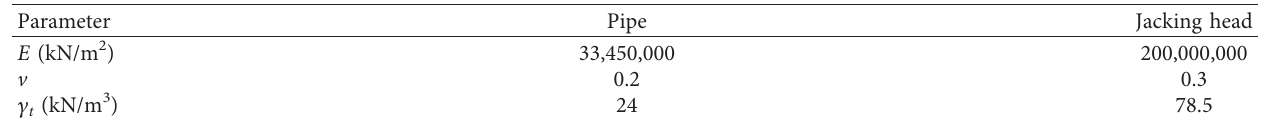
Table 4: Material parameters for the clay in project area (Drucker–Prager constitutive model was adopted to calculate the model). Parameter Soils Table 5: Material parameters for